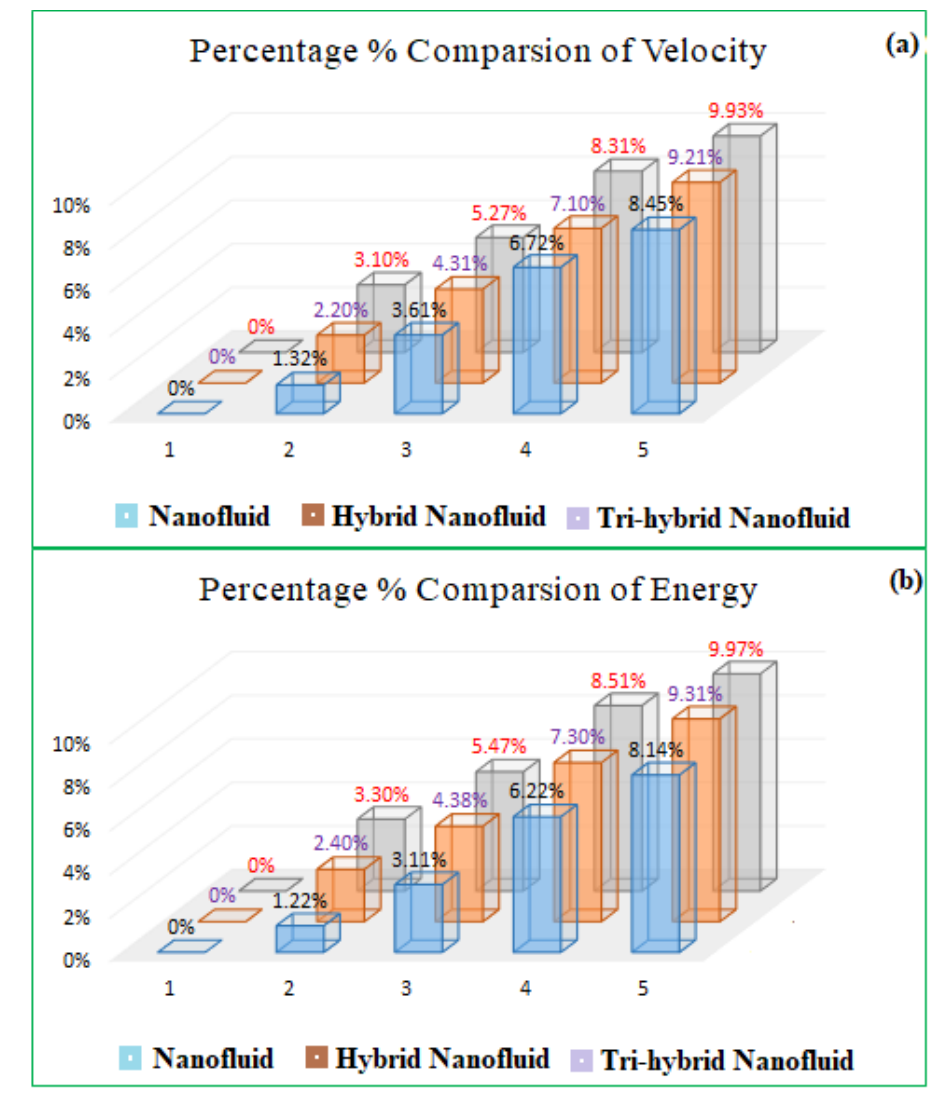
Figure 6. The percentage comparison of nanofluid, hybrid, and ternary hybrid nanofluid of velocity and energy in ( a ) and ( b ) respectively.